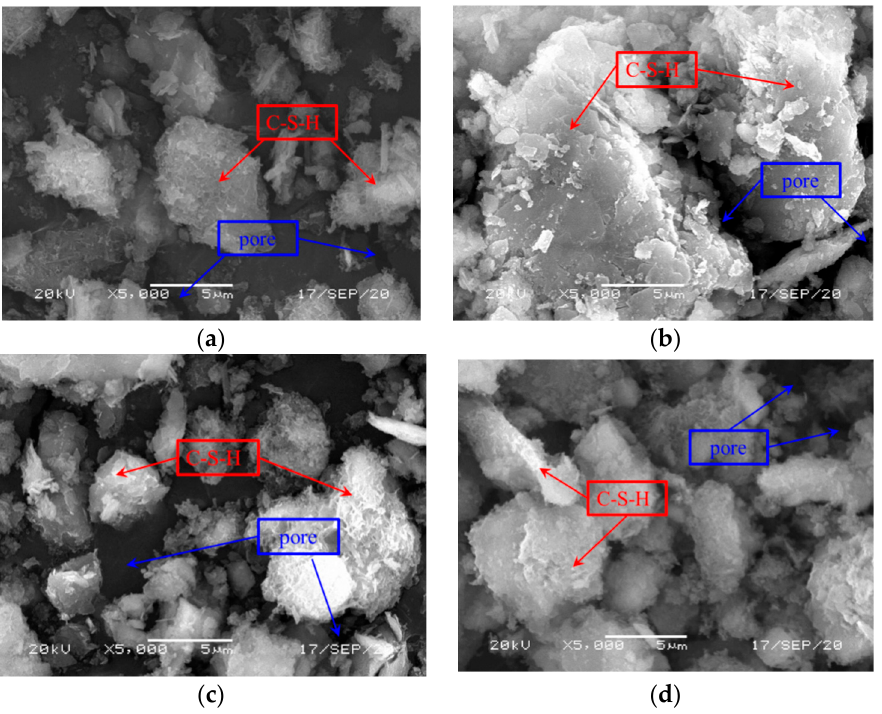
Figure 14. SEM images of different types of STCS. ( a ) STCS-0-0; ( b ) STCS-0-20; ( c ) STCS-0-40; ( d ) STCS-2.5-20.